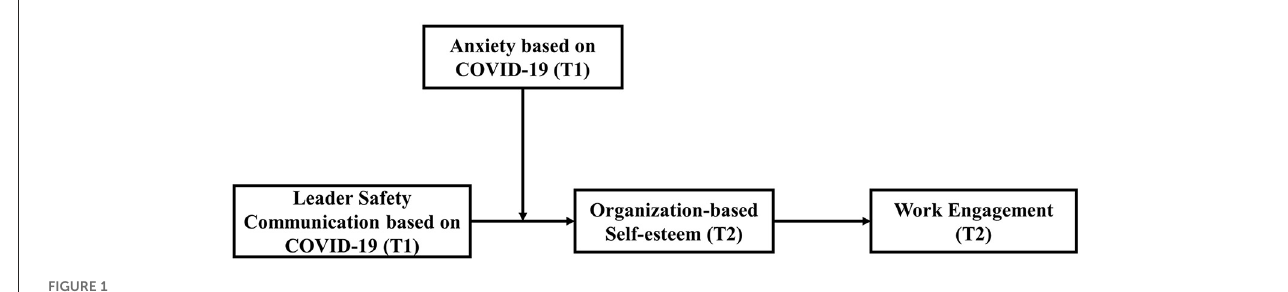
FIGURE1 Proposed theoretical